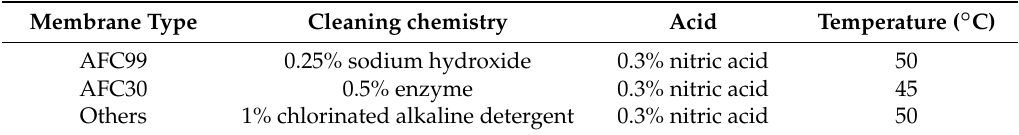
Table 2. Membrane cleaning characteristics